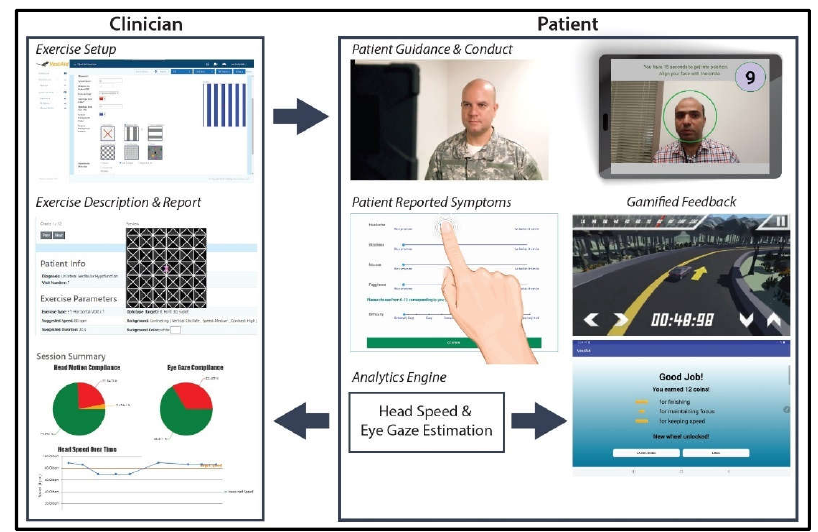
Table 1. Summary of VestAid software